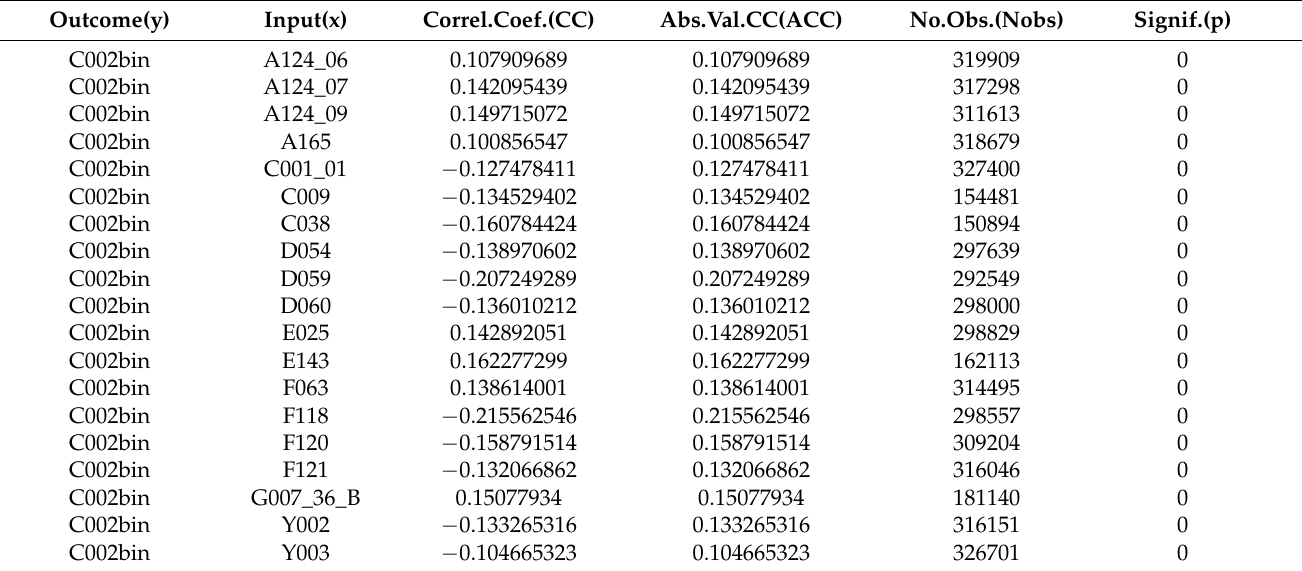
Table 1. Tabular view of the results of the second selection round based on magnitude of correlation coefficients, support, and